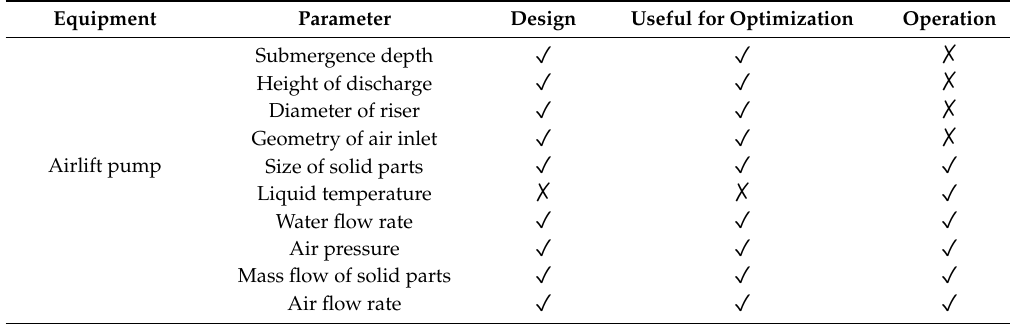
Table 2. Parameters of the airlift